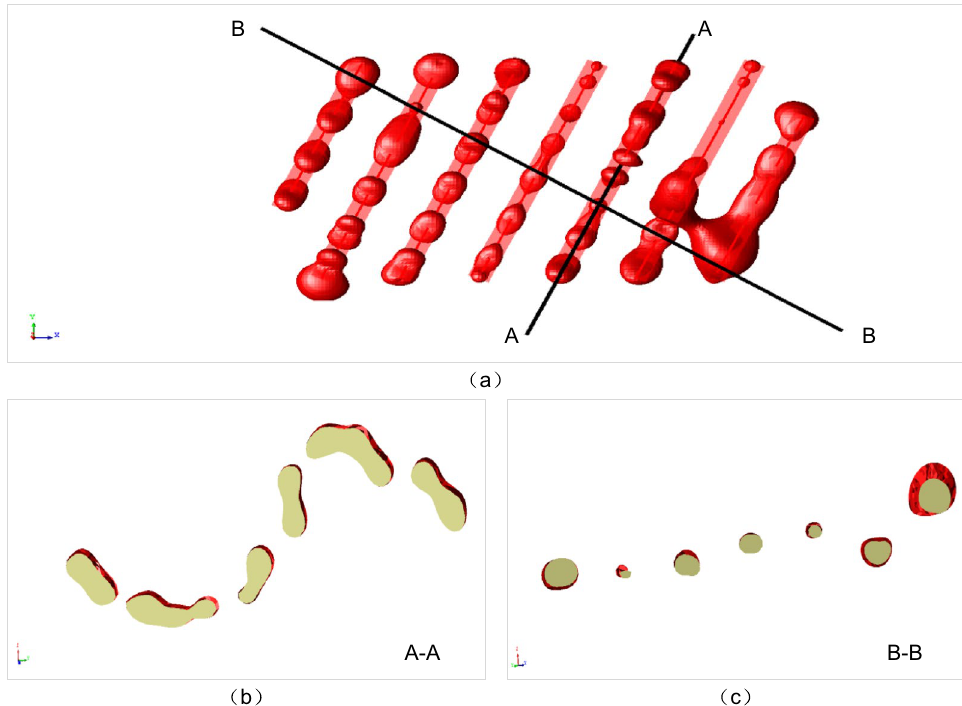
Figure 6. A failure example of the direct interpolation method without separating the HW and FW constraints for a vein type ore body. ( b , c ) The details of the reconstructed model ( a ) by cutting along the A-A and B-B